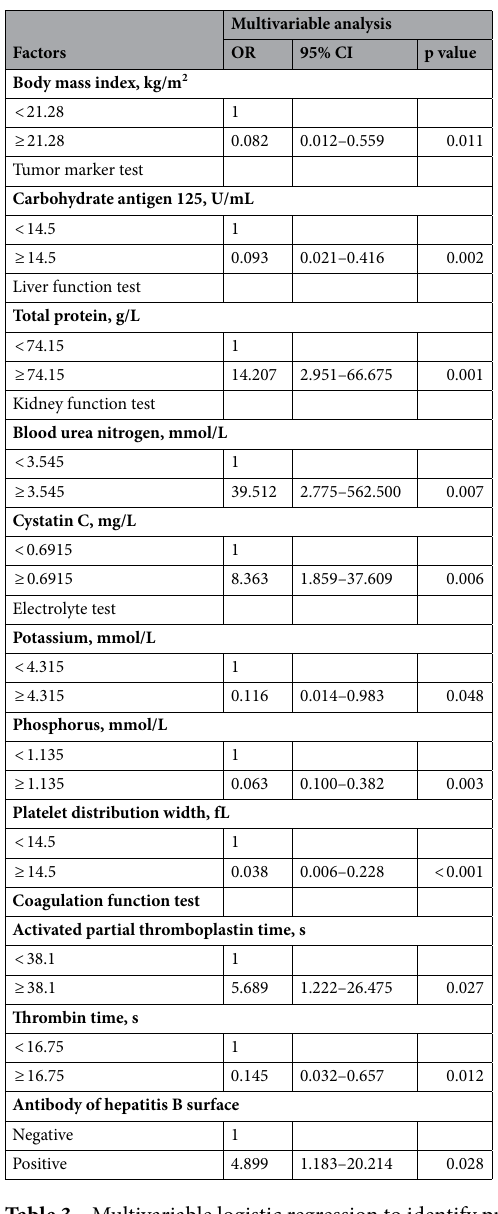
Table 3. Multivariable logistic regression to identify predictors of bpCR after NAC based on clinicopathological characteristics and serological indicators. NAC neoadjuvant chemotherapy, bpCR breast pathological complete